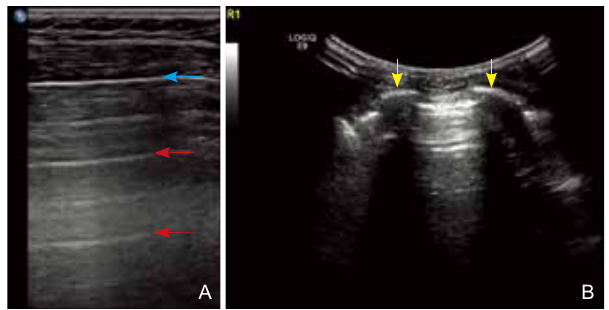
Figure 1 (A) Normal lung sonography by linear probe. The pleura line is a linear reflection formed by the interface echo between pleura and lung surface (blue arrow). A-line (red arrow) is parallel to and equidistant from the pleura line, and the distance between the pleural line and the A-line is equal to the distance between the skin and the pleural line. (B) Intercostal longitudinal section by convex array probe shows hyperechoic upper and lower ribs and the shadow behind (yellow arrow), the linear hyperechoic pleural line in between. Together with the parallel A-line artifacts beneath pleural line, a “bat sign” is displayed.